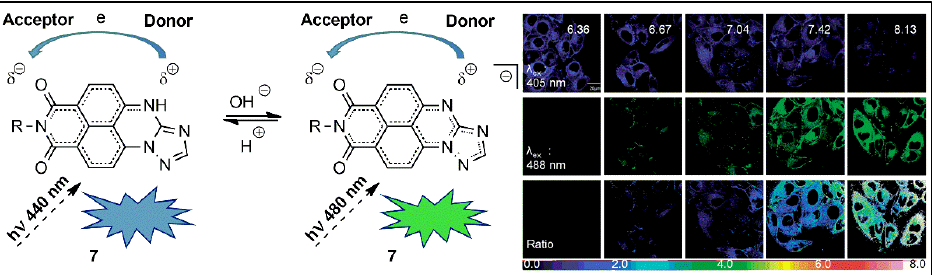
Figure 7. Sensing process of probe 7 . Confocal fluorescence images of MCF–7 cells incubated in high K+ HEPES-buffered solution containing ionophores at different pHs. Reproduced with permission from [50]. Copyright (2012) The Royal Society of